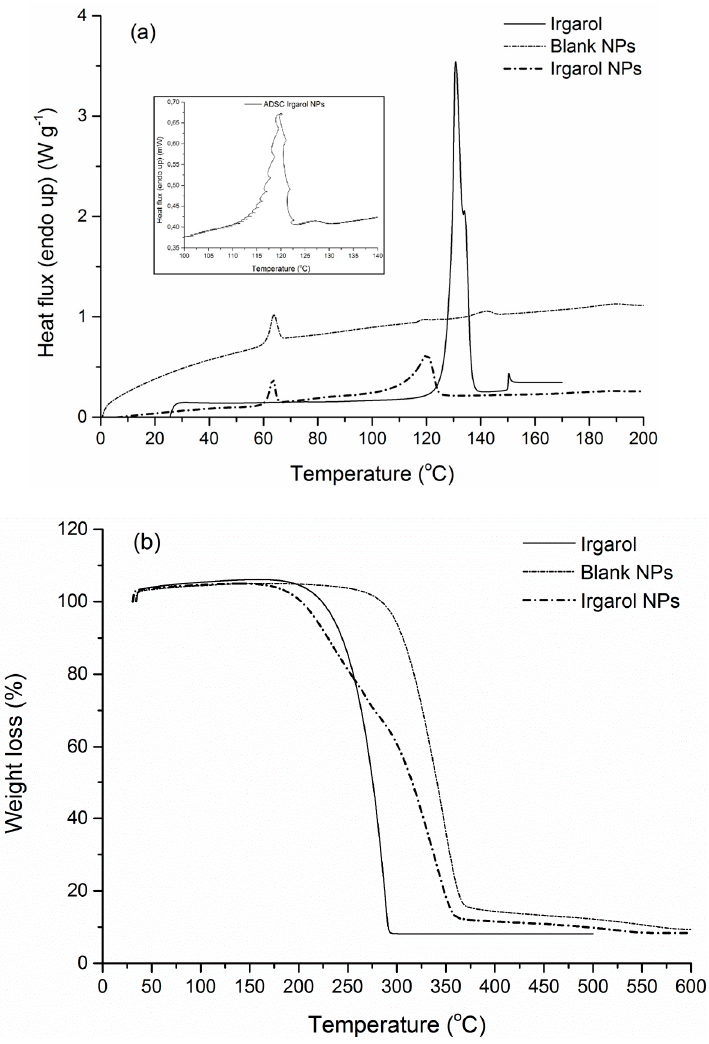
Figure 8. ( a ) DSC and ( b ) TGA curve of Irgarol NPs and comparison curves.